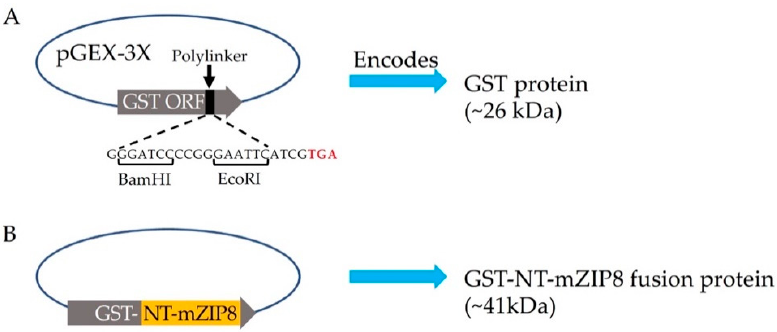
Figure 2. Schematic representation of pGEX-3X vector and the construction strategy for the plasmid encoding GST–NT-mZIP8. ( A ) The pGEX-3X vector contains the open reading frame (ORF) of GST followed by an expanded polylinker with restriction-enzyme cut sites upstream of the stop codon TAG (red letters). ( B ) the N-terminal sequences encoding serine 30 to serine 124 of mZIP8 (NT-mZIP8, orange) were cloned into pGEX-3X vector using BamHI/EcoRI sites to generate the recombinant plasmid pGEX-3X-GST–NT-mZIP8. The predicted molecular mass for GST was 26 kDa, and the anticipated product size for GST–NT-mZIP8 was 41 kDa.